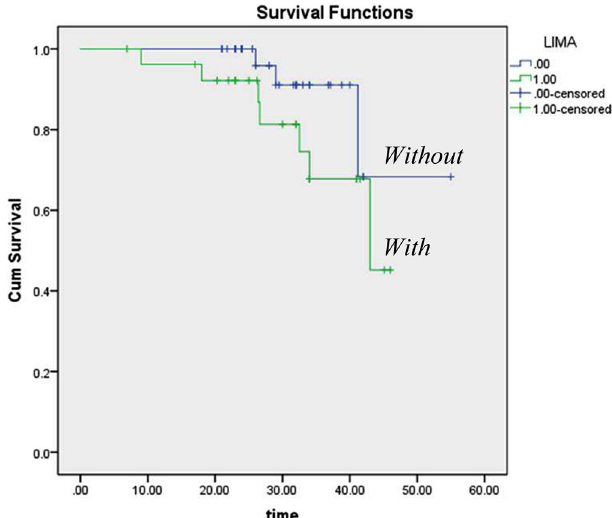
Fig. 2 - Kaplan-Meier analysis revealed that the pathological changes of the left internal mammary graft artery were a risk factor that negatively influenced the survival rate. The long-term survival rate was 83.9%, 74.1% and 91.4% for overall and patients with and without pathological changes of the left internal mammary artery. LIMA=Left internal mammary artery; With=With pathological changes; Without=Without pathological